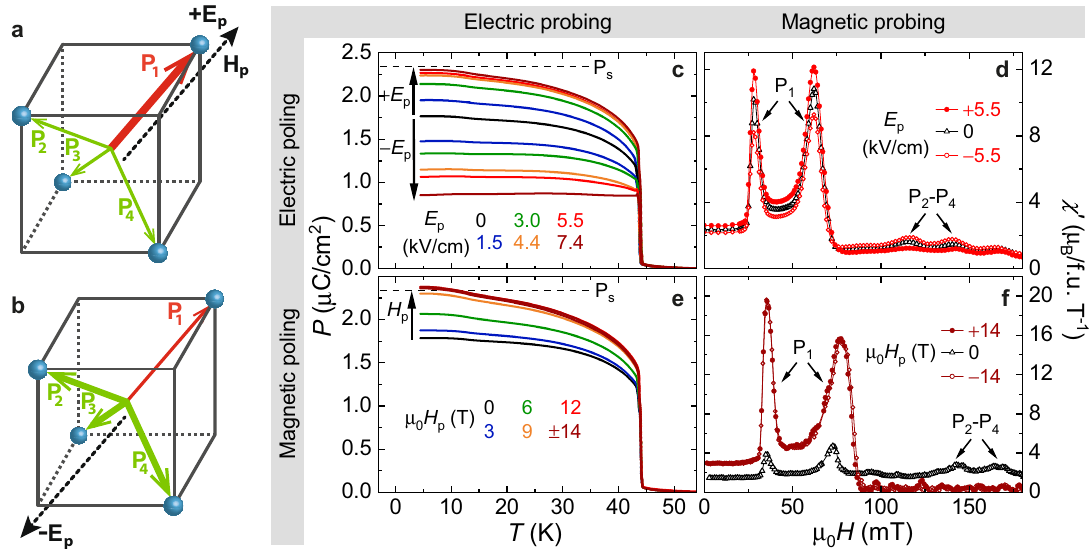
Fig. 1 Electric and magnetic control/readout of multiferroic domain population in GaV 4 S 8 . a , b Schematics about the domain selection process by electric ( E p ) and magnetic ( H p ) poling fi elds applied along the [111] axis. Polarizations of the four domain states, P 1 – P 4 , are indicated with respect to the undistorted V 4 tetrahedron of the cubic phase. Thick/thin arrows correspond to domains favored/unfavoured by the poling. c , d Temperature-dependent polarization/ fi eld-dependent susceptibility at 11.5 K and their variation with E p . e , f Temperature-dependent polarization/ fi eld-dependent susceptibility at 11.5 K and their variation with H p . In all cases polarization along the [111] axis and susceptibility for H ∥ [111] were